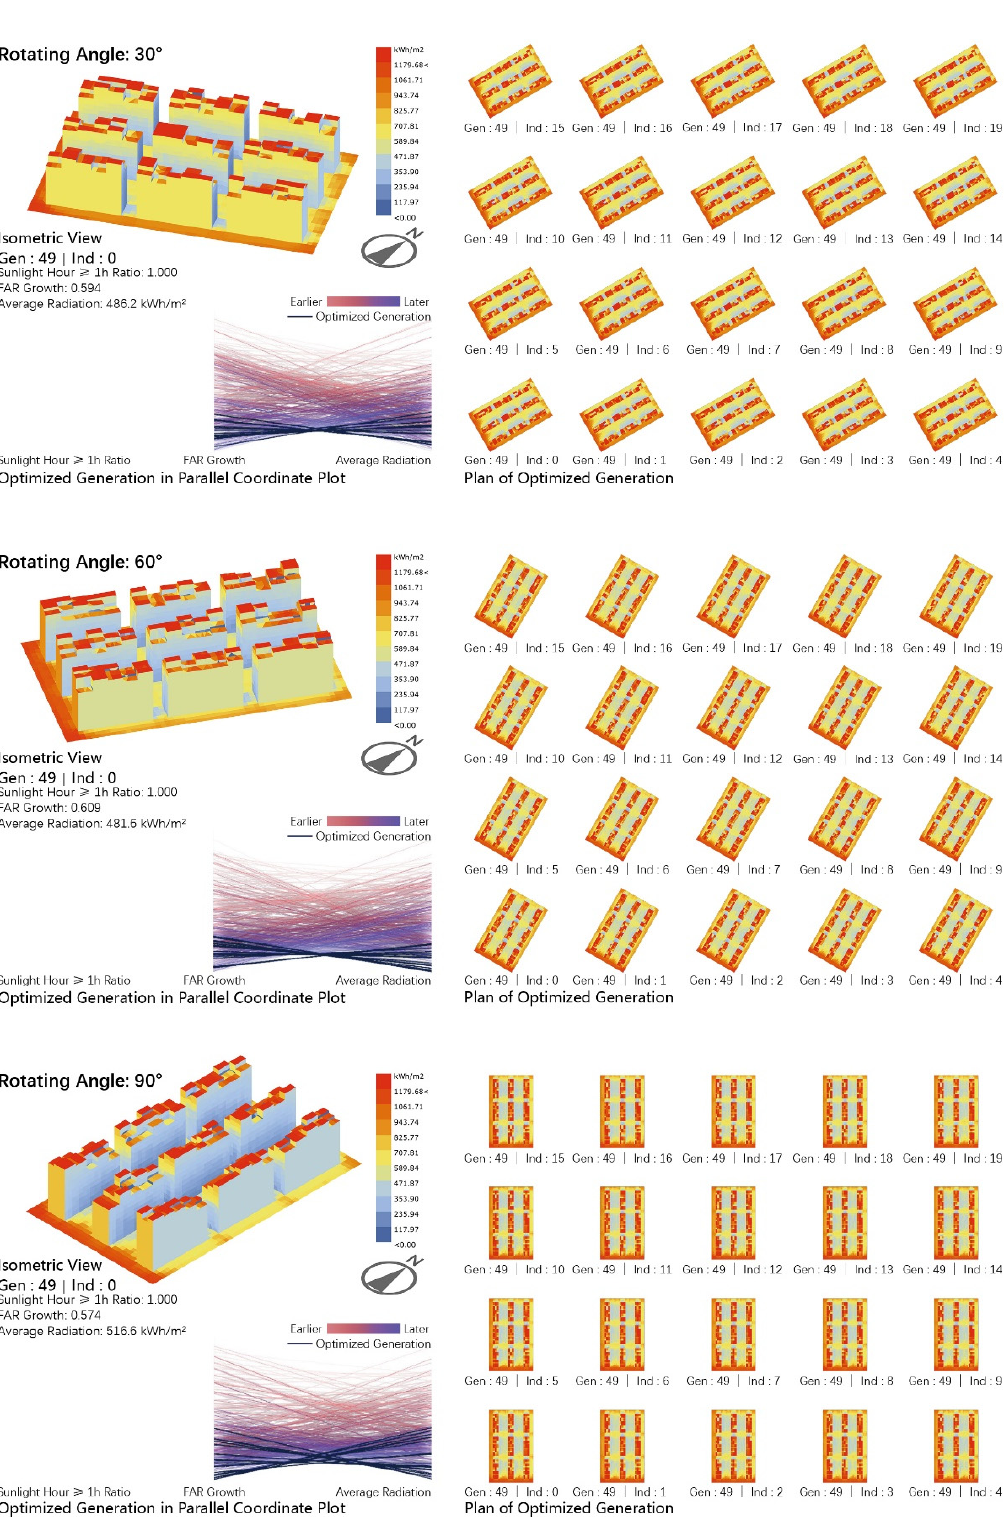
Figure 12. Solutions of the vertical addition mode for the varied orientations.